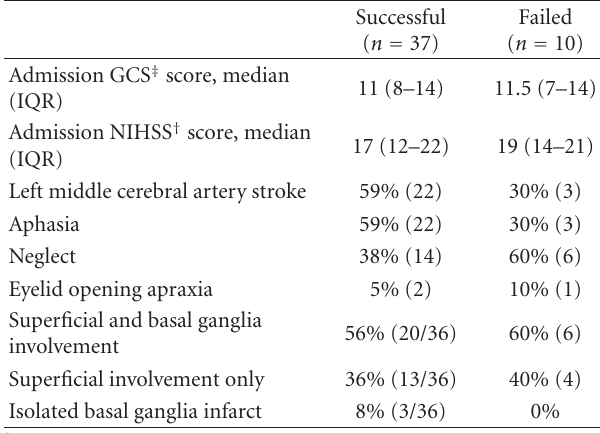
Table 2: Baseline clinical characteristics of middle cerebral artery acute ischemic stroke patients in whom extubation was successful versus failed ∗